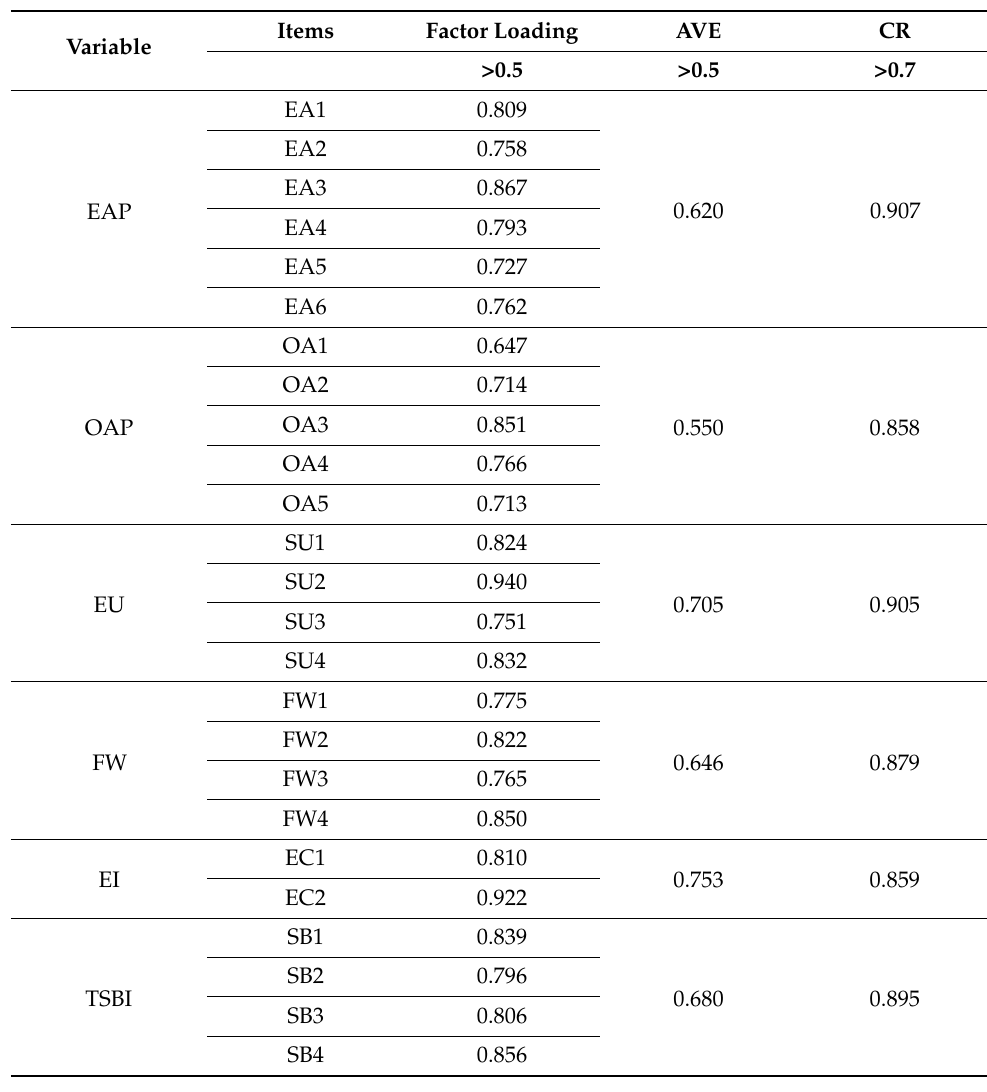
Table 2. Confirmatory factor analysis.